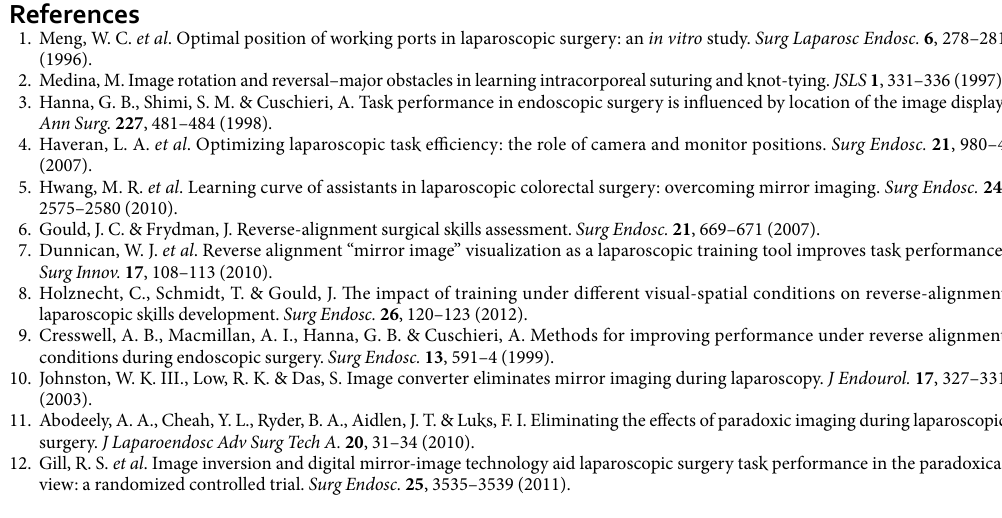
and Mirror image + Monitor on the left side of the participant + Camera rotated 90 degrees to the right (M + Mon + Cam) with the training box (Endowork-Pro II, KARL STORZ SE & Co, Tuttlingen, Germany). The camera was placed 15 cm from the target. The monitor was placed 100 cm from the eyes of each participant.